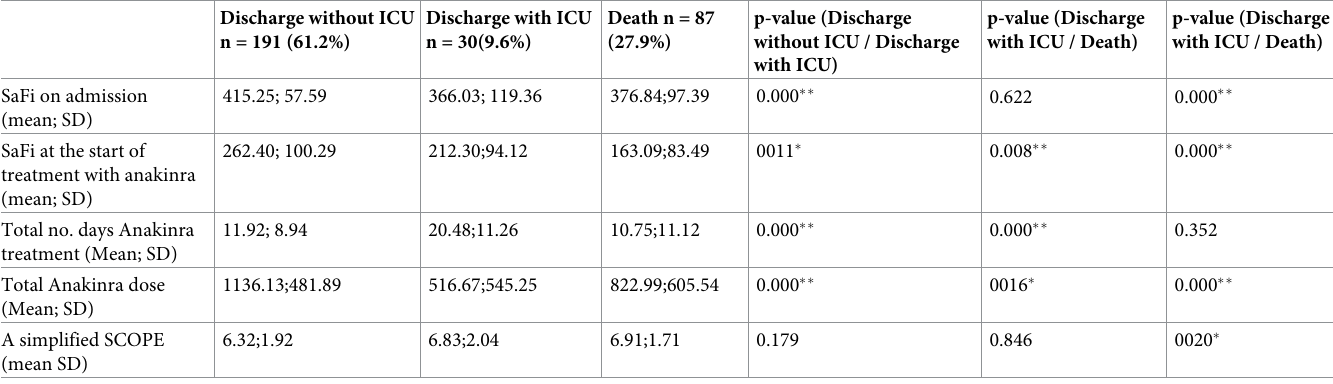
Table 2. Clinical outcome at 60 days based on SaFi, anakinra and a simplified SCOPE.